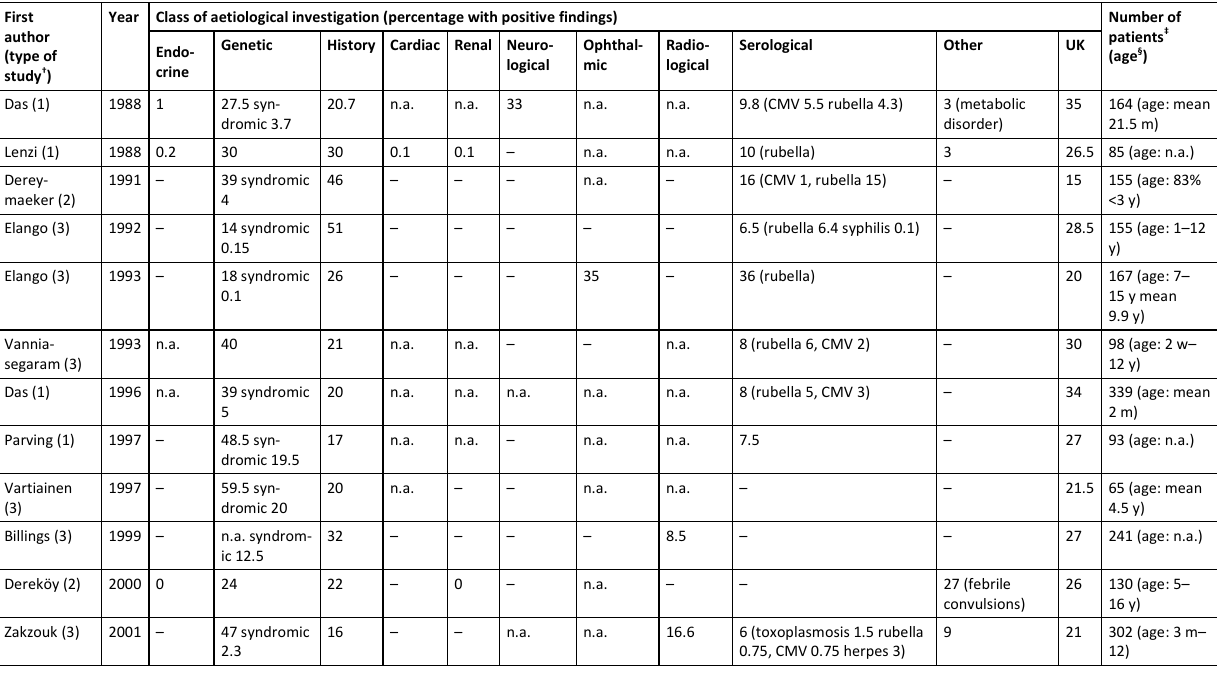
Table 1 : List of studies (in chronological order) with >1 aetiology